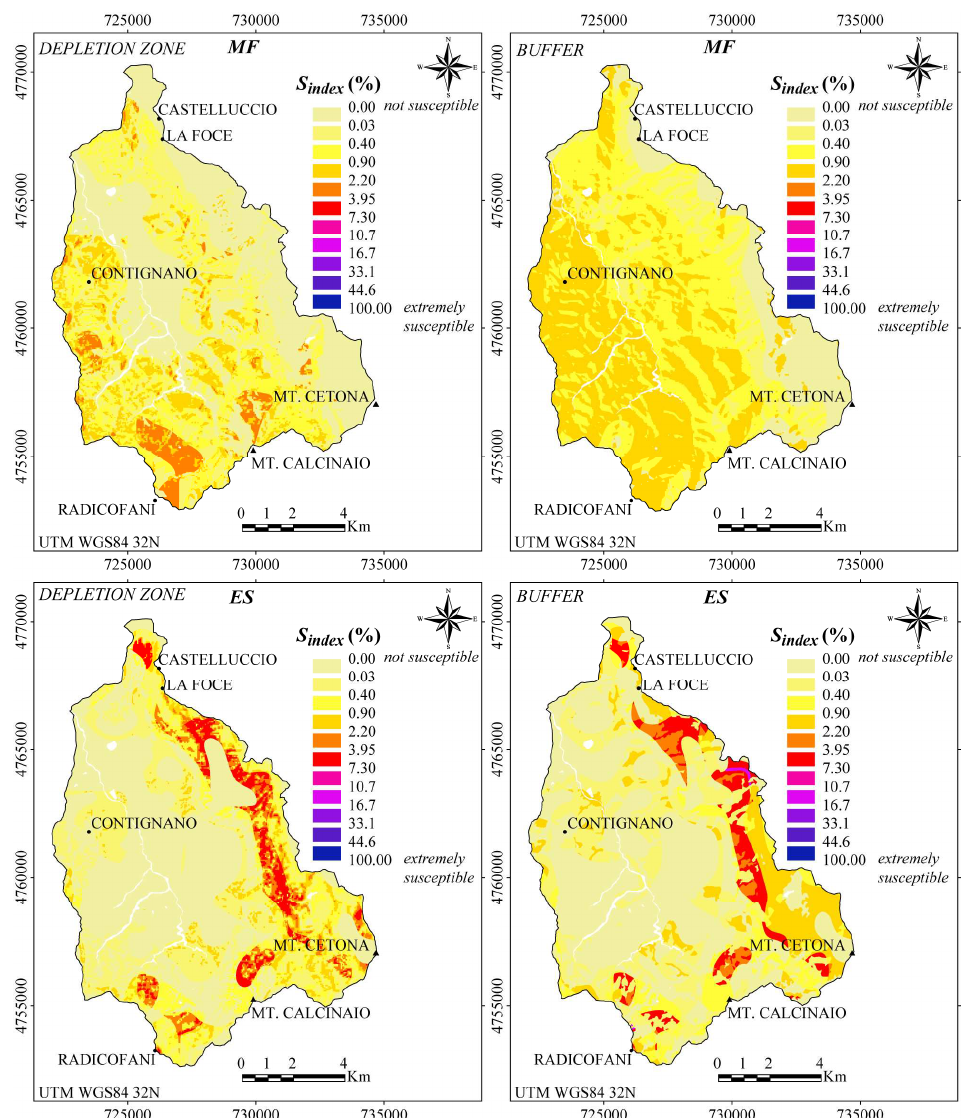
Fig. 9a. Susceptibility maps of the Upper Orcia Valley obtained through the conditional analysis for each landslide type. For each landslide type, the susceptibility index ( S index ) values correspond to the conditional probability of the landslide event, given the selected number of causal factors. S index values are classified in 11